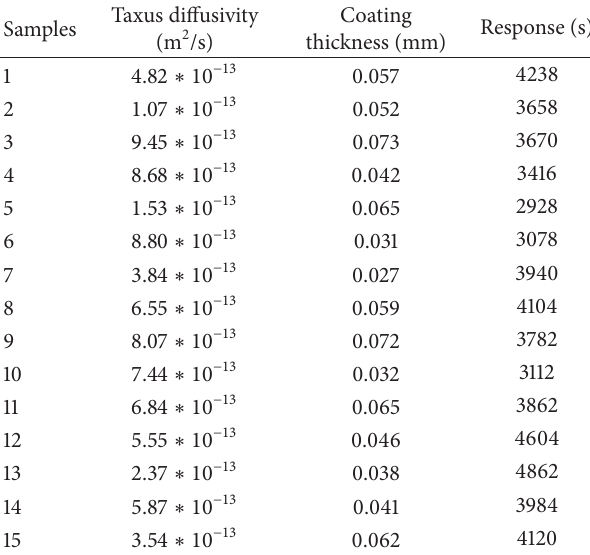
Table 1: Samples and